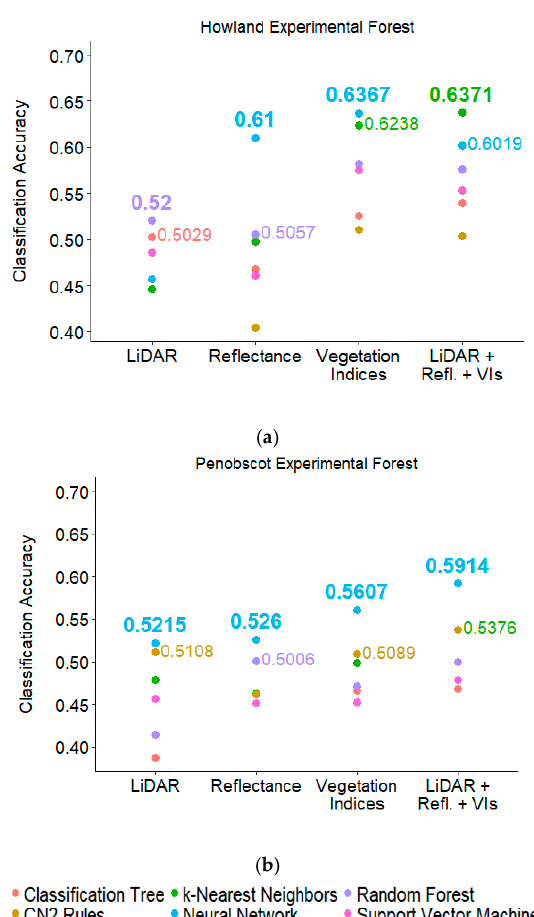
Figure 3. Comparison of resampling techniques and machine learning methods using complete lists of metrics. Figure shows classification accuracies achieved by machine learners run on full datasets from Howland Experimental Forest ( a ) and Penobscot Experimental Forest ( b ). From left to right, columns represent classification accuracies produced with light detection and ranging (LiDAR) data, hyperspectral reflectance data, vegetation indices (VIs) calculated from these reflectance data, and a combined dataset of LiDAR and both types of hyperspectral data.